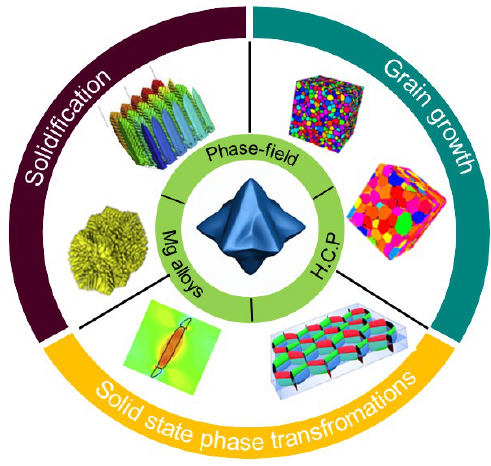
Figure 1. Graphical abstract.